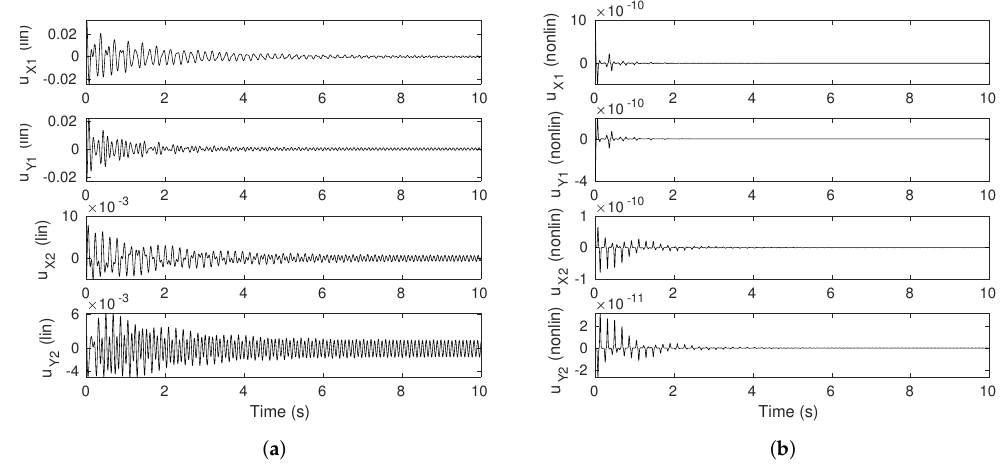
Figure 9. Control vector u applied to the displacements with γ = − 0.1 and µ = 0.4. ( a ) Linear contribution. ( b ) Nonlinear contribution.